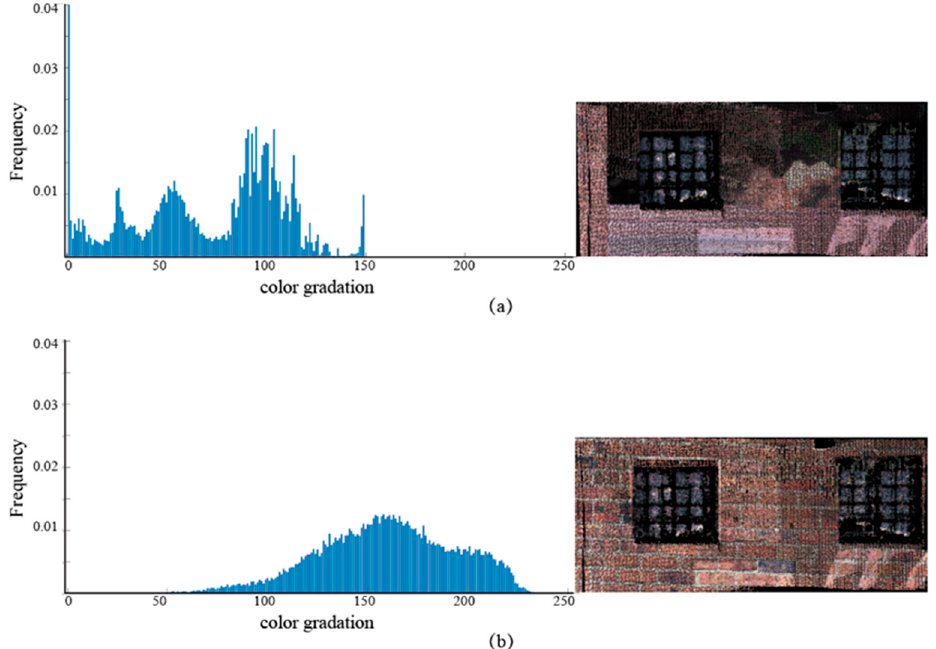
Figure 18. Color histogram of the wall extracted from the Wesley House (corresponding to Figure 15).